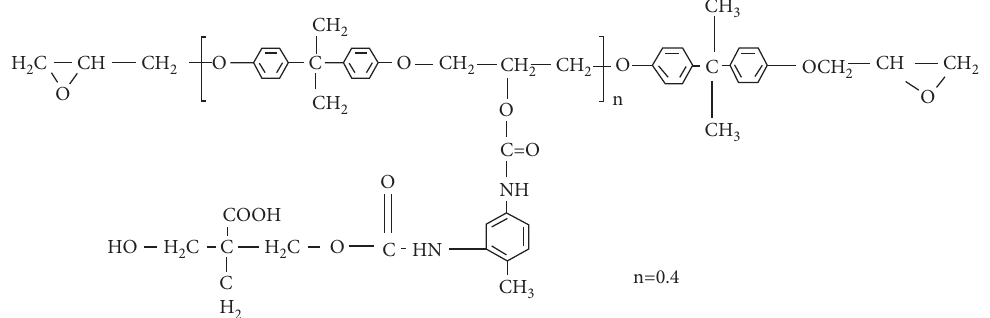
Figure 6: Molecular structural formula of waterborne epoxy resin